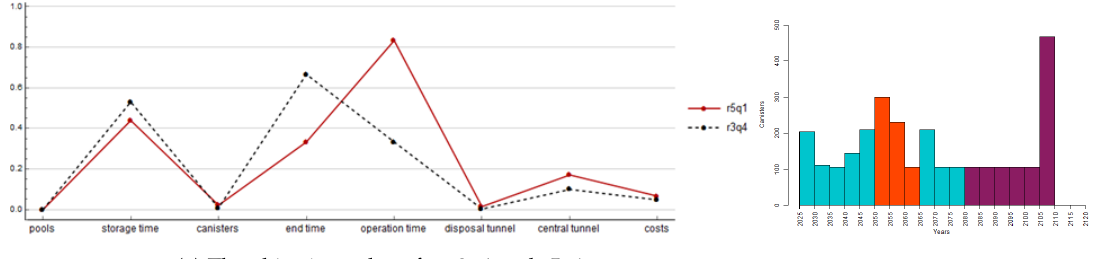
Figure 9. Result without